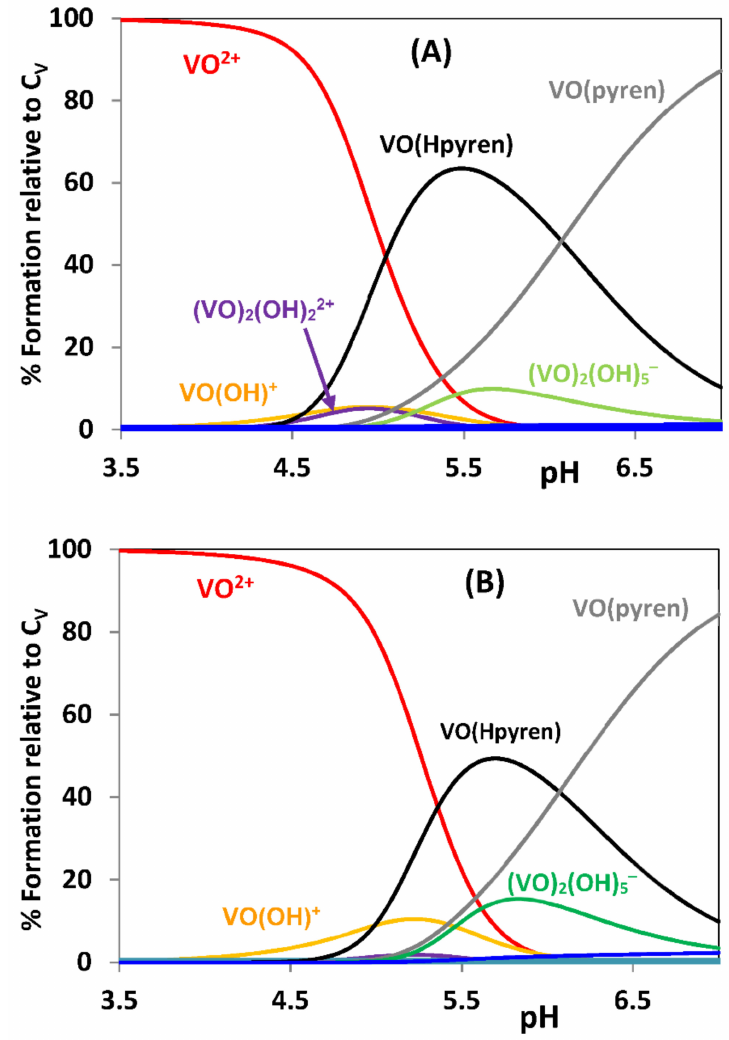
Figure 8. Species distribution diagrams of V IV O-complexes formed in solutions containing V IV O 2+ and H 2 pyren, with C V = C pyren = 100 µ M ( A ) and 10 µ M ( B ), assuming the formation constants determined are valid up to pH = 7. [V IV O(Hpyren)] + corresponds to [V IV O(pyren)] protonated at one of the pyridine N -atoms. In both complexes the pyren ligand binds in a tetradentate fashion to V IV